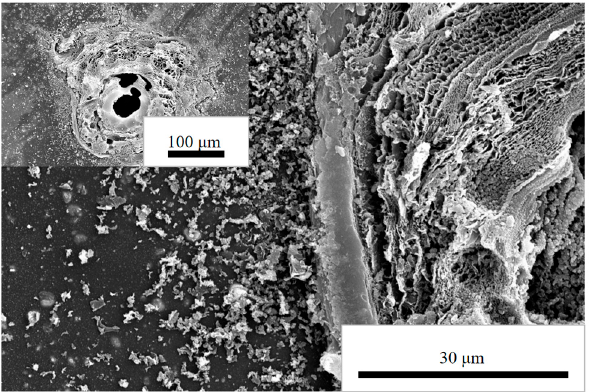
Figure 4. SEM surface morphology near the corona breakdown point of PI/nano-SiO 2 composite film with doping amount of 5 wt%.